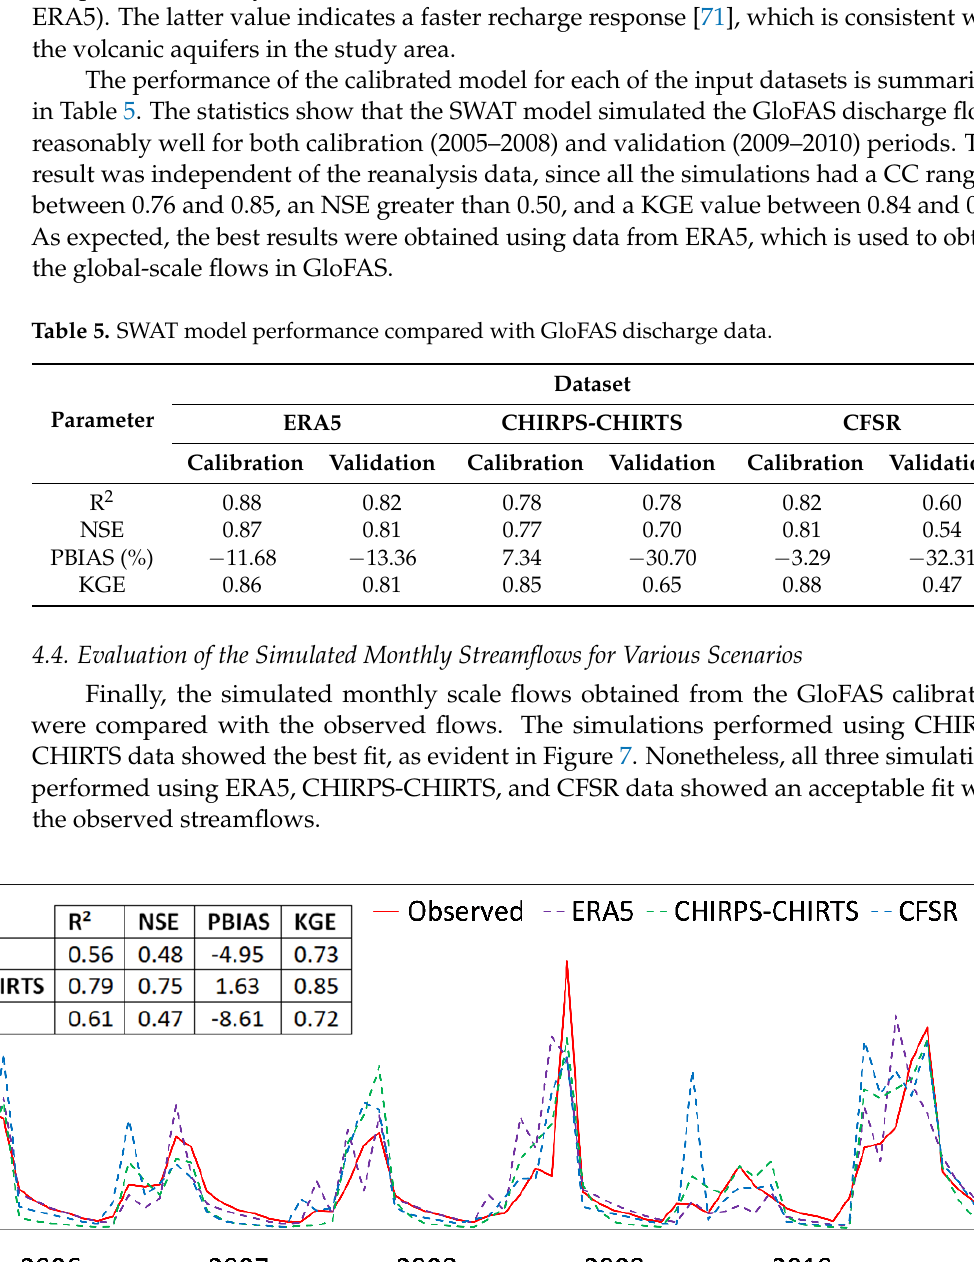
Table 5. SWAT model performance compared with GloFAS discharge data.